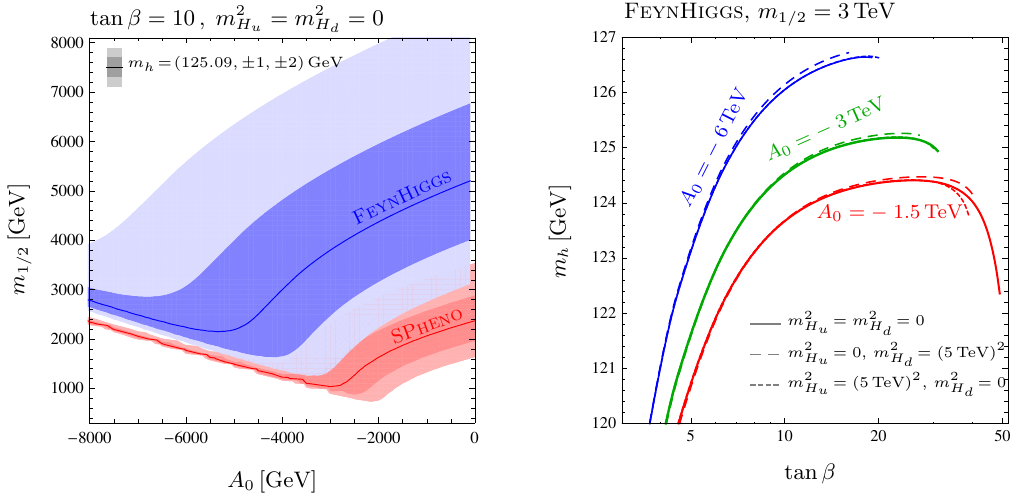
Figure 1 . Left panel: contours of the Higgs mass computed by SPheno (red curve) and FeynHiggs (blue curve) in the A 0 - m 1 = 2 plane. The solid lines denote the contour where m h = 125 : 09 GeV whereas the corresponding darker and lighter shaded areas around them de- note a deviation of (cid:6) 1 and (cid:6) 2 GeV, respectively. Right panel: dependence of the Higgs mass, m h , computed by FeynHiggs , on tan (cid:12) for m = 3 TeV and three choices of the 1 = 2